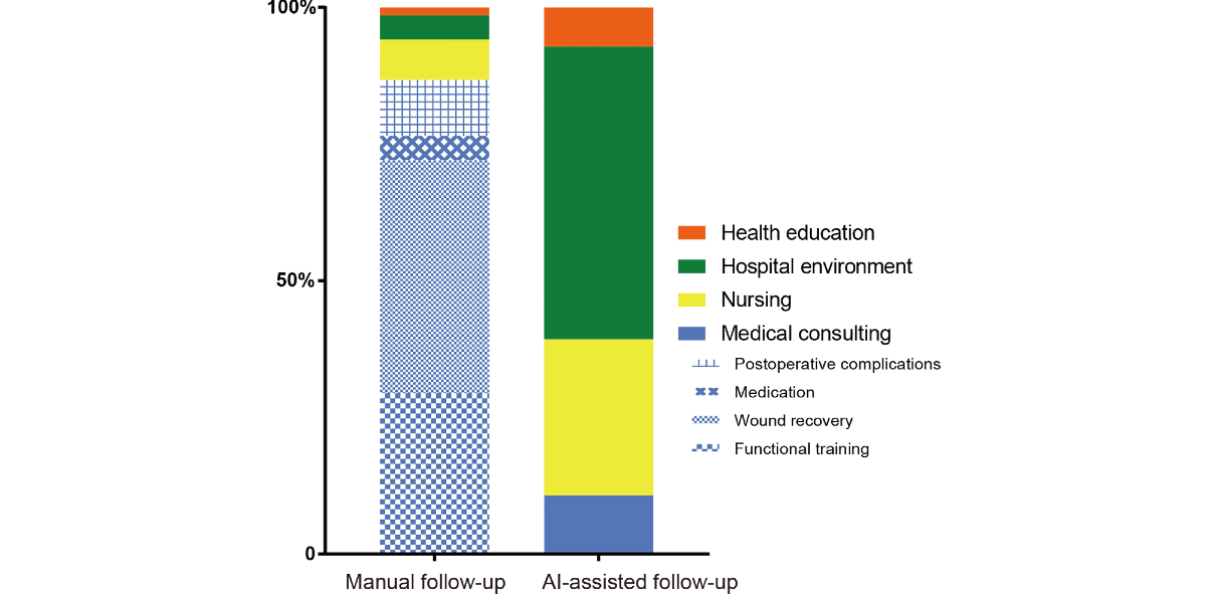
Figure 2. Composition of feedbacks in AI-assisted follow-up group and manual follow-up